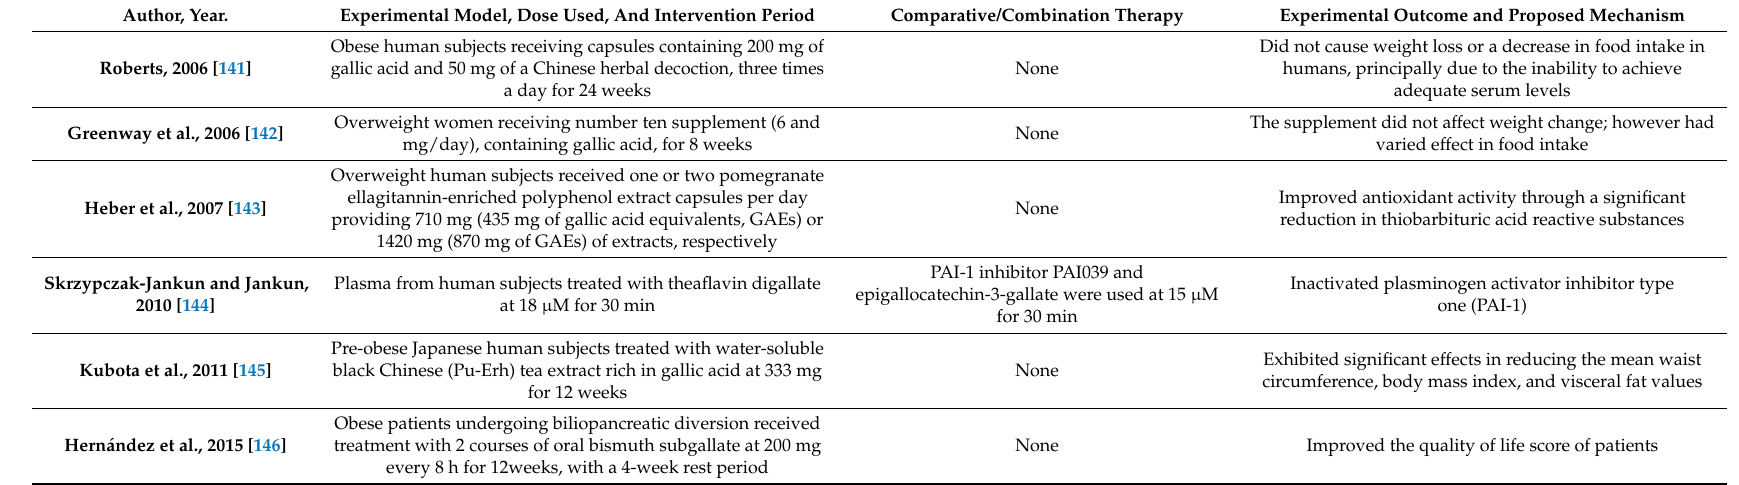
Table 5. Human studies reporting on the therapeutic potential of gallic acid or gallic acid rich plants against obesity-associated complications. Author,